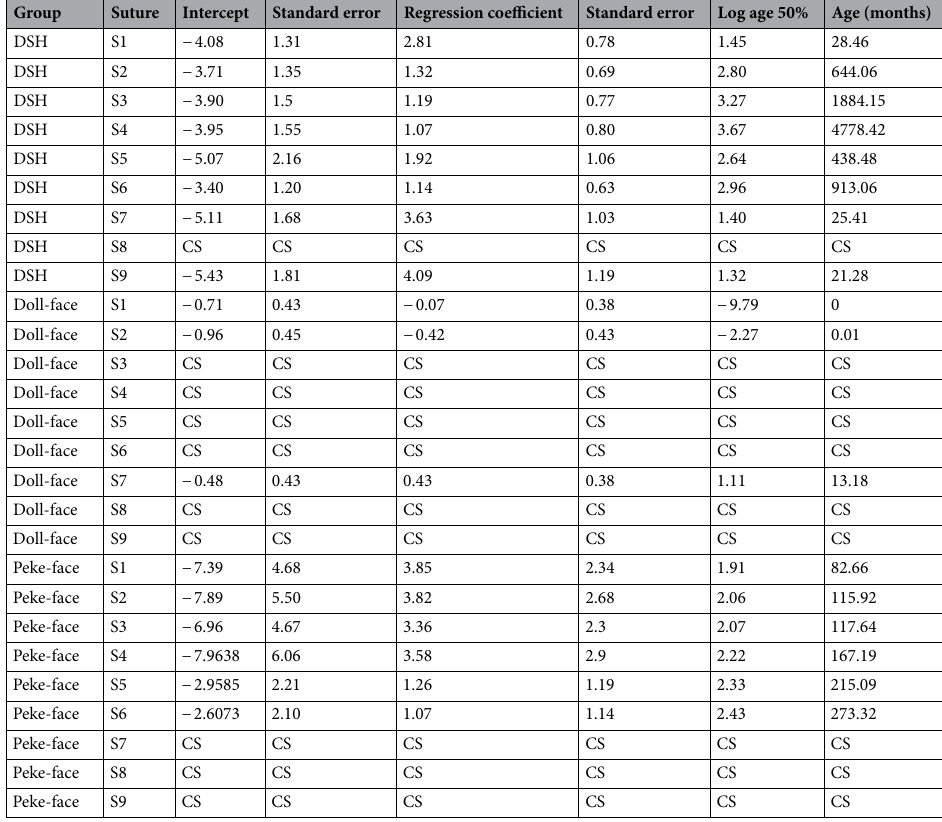
Table 2. Overview of the results of logistic regression analysis to determine the 50% probability of having a closed suture/synchondrosis. CS complete separation, DSH Domestic Shorthair cat, S1 sagittal suture, S2 metopic suture, S3 left coronal suture, S4 right coronal suture, S5 left lambdoid suture, S6 right lambdoid suture, S7 intersphenoid synchondrosis, S8 spheno-occipital synchondrosis, S9 spheno-ethmoid